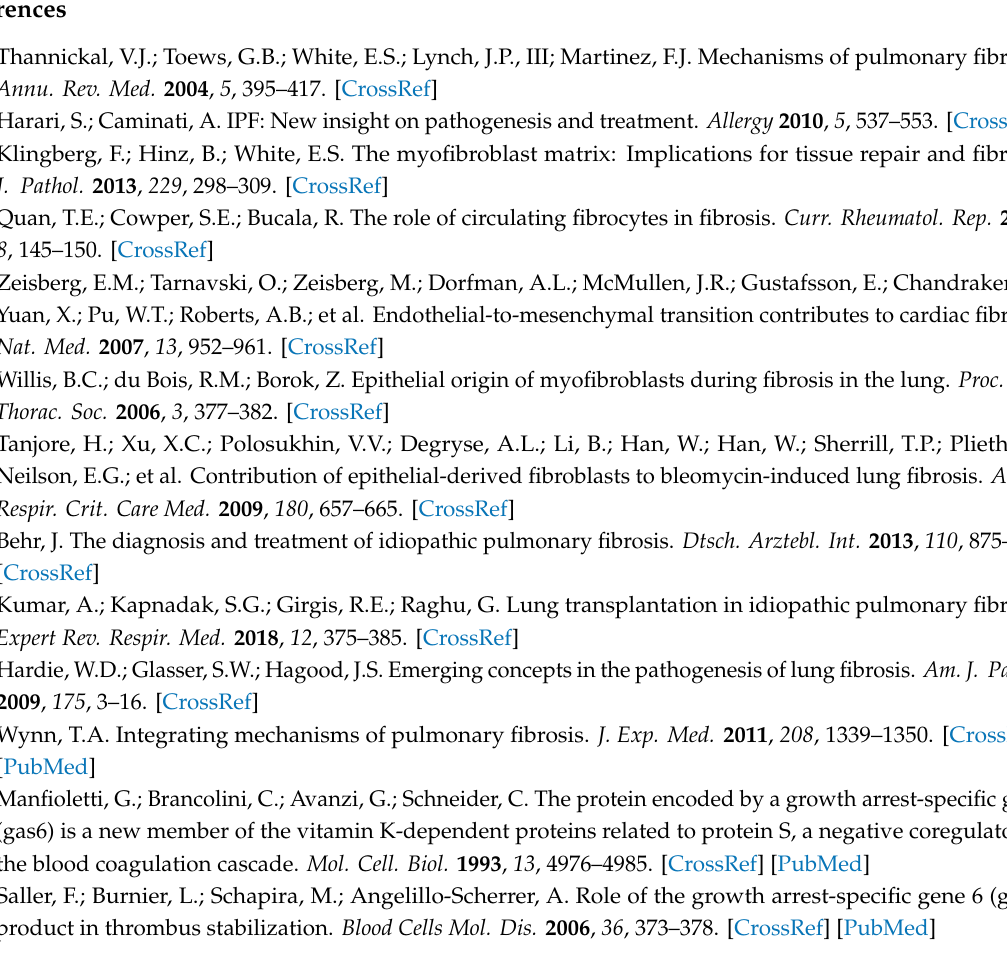
Figure S1: Gas6 induces RhoA activity, HGF production and c-Met expression in lung epithelial cells, Figure S2: Gas6 / Axl or Mer signaling enhances RhoA activity and expression levels of HGF and c-Met in lung epithelial cells, Figure S3: Gas6 induces inhibition of EMT in LA-4 cells via RhoA, Figure S4: Gas6 induces inhibition of non-Smad signaling pathways and EMT transcription factors in LA-4 cells via